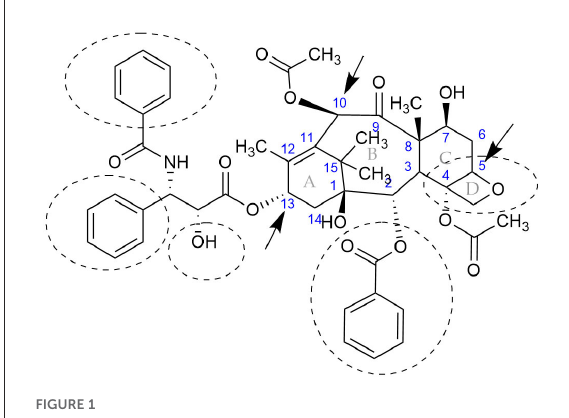
FIGURE1 Chemical structure of the anticancer compound, paclitaxel, better known by its registered name, Taxol ® . The central rings are specified with the letters A, B, C, and D, while the carbons are numbered in blue according to (Nicolaou et al., 1994). The compound is produced by Taxus spp., some fungi, actinomycetes, and, most recently, bacteria isolated from marine macroalgae. Some fungal endophytes could modify the functional groups at C-10 and C-13 (indicated by arrows at rings B and A, respectively), or modify the oxetane (ring D) and convert the paclitaxel into less active metabolites (Kingston, 1994; Hu et al., 1996; Zhang et al., 1998; Baloglu and Kingston, 1999). Functional groups that are known to be required for activity are encircled with dashed lines (Kingston,